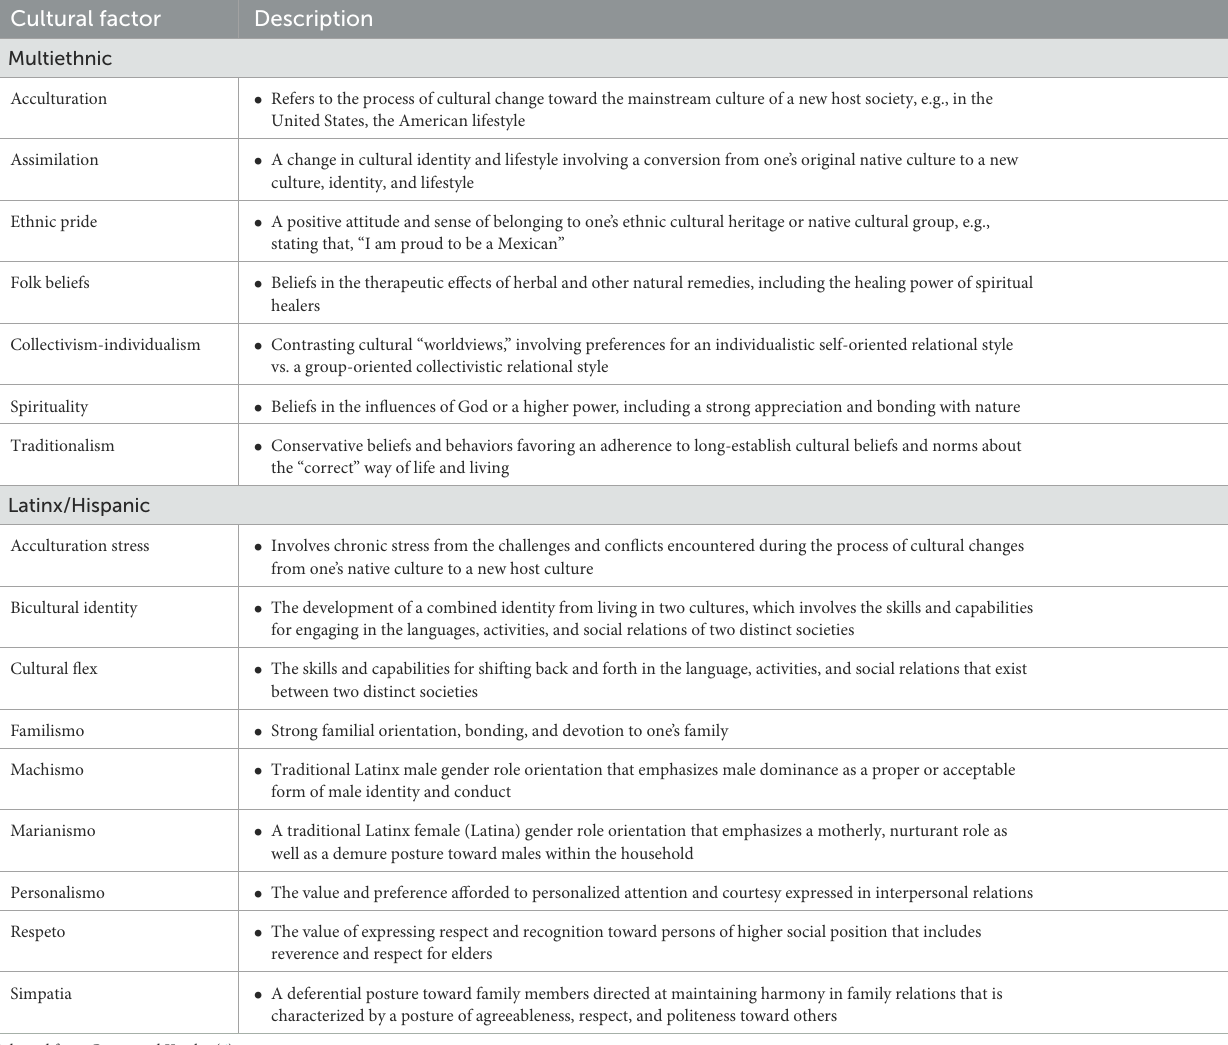
TABLE 1 Major cultural factors in the Latinx research